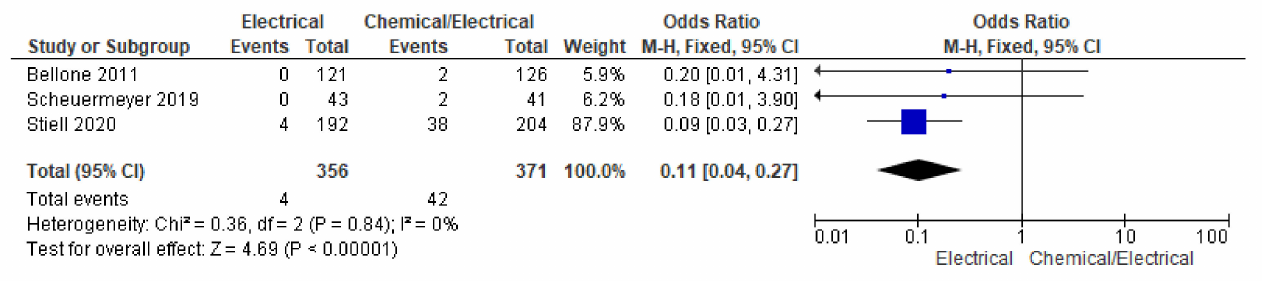
Figure 6. Forest plot showing significant hypotension across electrical and chemical followed by electrical cardioversion group using fixed effect model among RCTs